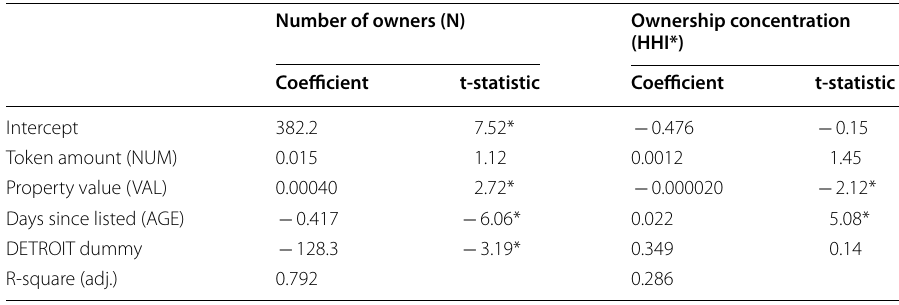
Fig. 2 Histogram of ownership concentration per property. Figure based on data from March 2021. Contains ownership of the 58 properties in Table 1